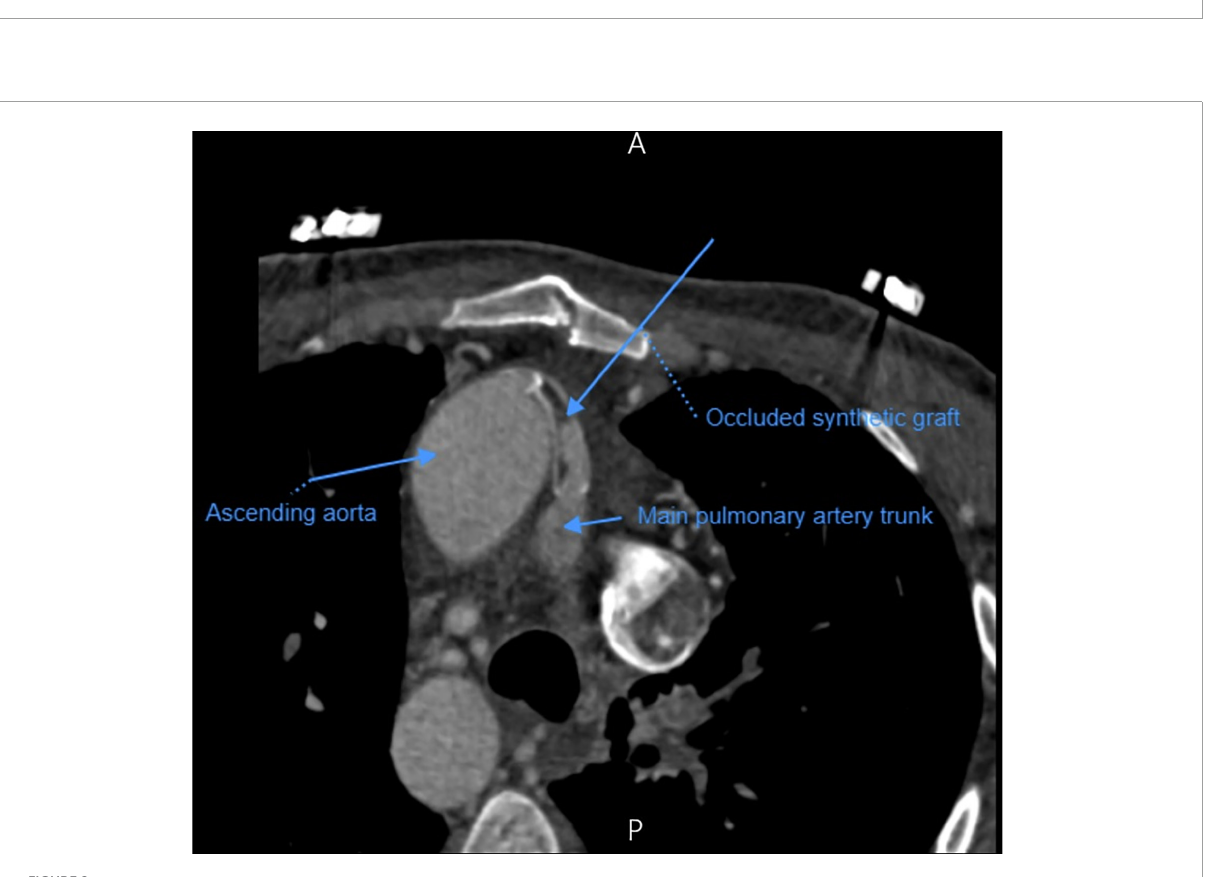
FIGURE2 CT-scan showing occlusion of central aorto-pulmonary